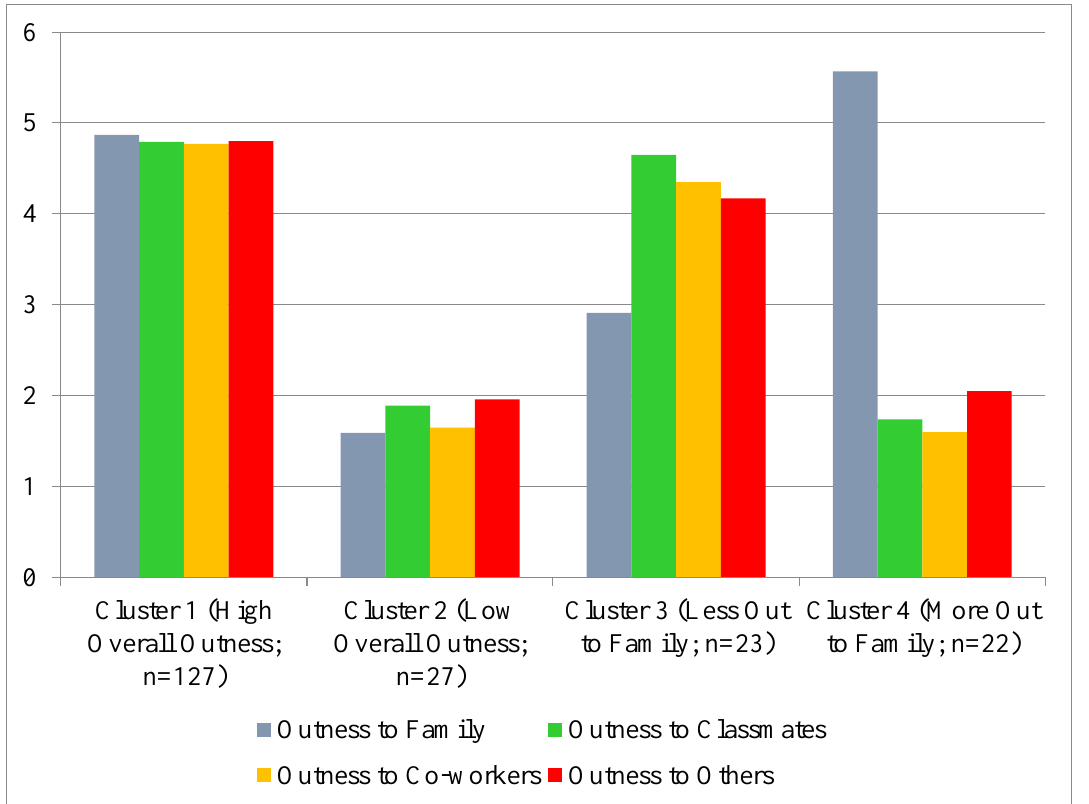
Figure 2. The cluster type means on outness to relational subgroups.